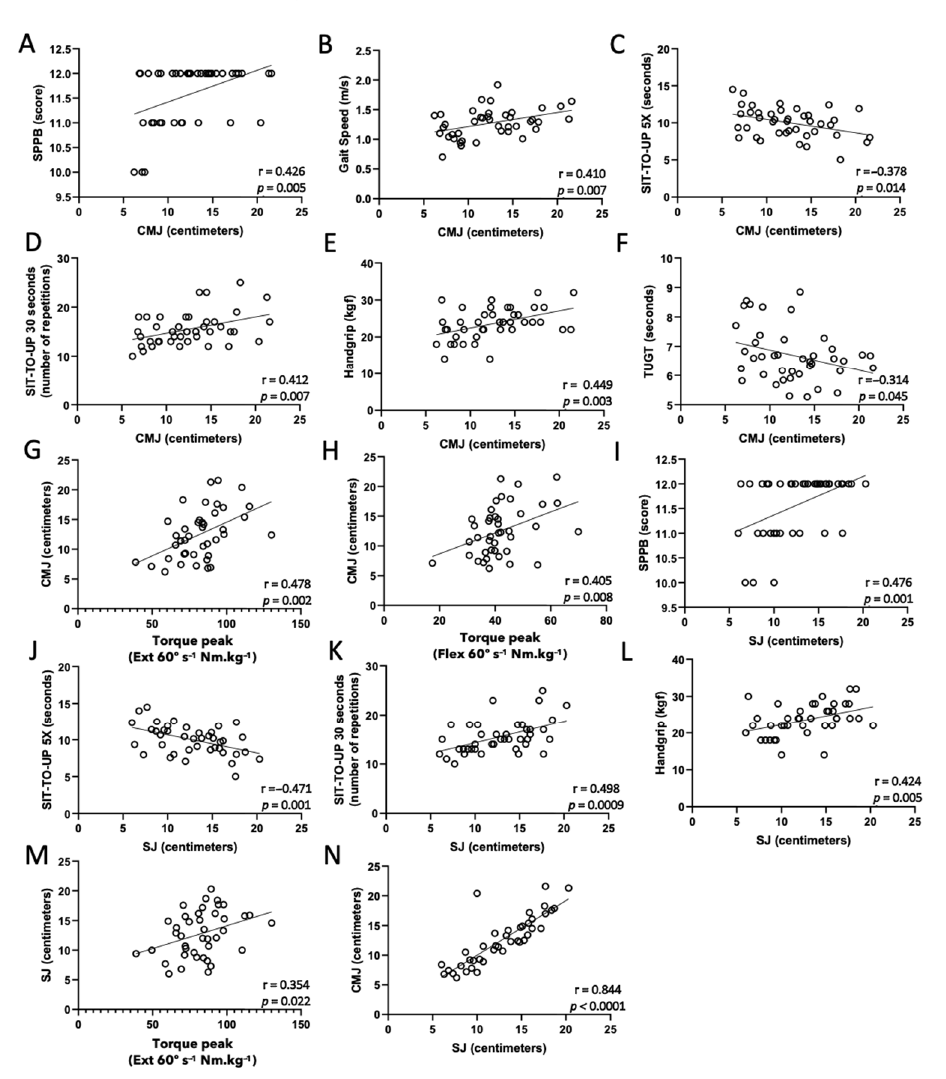
Figure 2. Pearson’s coefficient correlation analysis of vertical jump tests in two styles: countermove- ment jump (CMJ, ( A – H )) and squat jump (SJ, ( I – M )); physical function tests (SPPB, ( A , I ); gait speed, ( B ); sit-to-up 5X, ( C , J ); sit-to-up 30 s, ( D , K ); handgrip, ( E , L ); TUGT, ( F )). Isokinetic tests: knee muscles at 60 degrees per second (extensor, ( G , M ); flexor, ( H )); between CMJ and SJ ( N ). Significance level: p < 0.05.